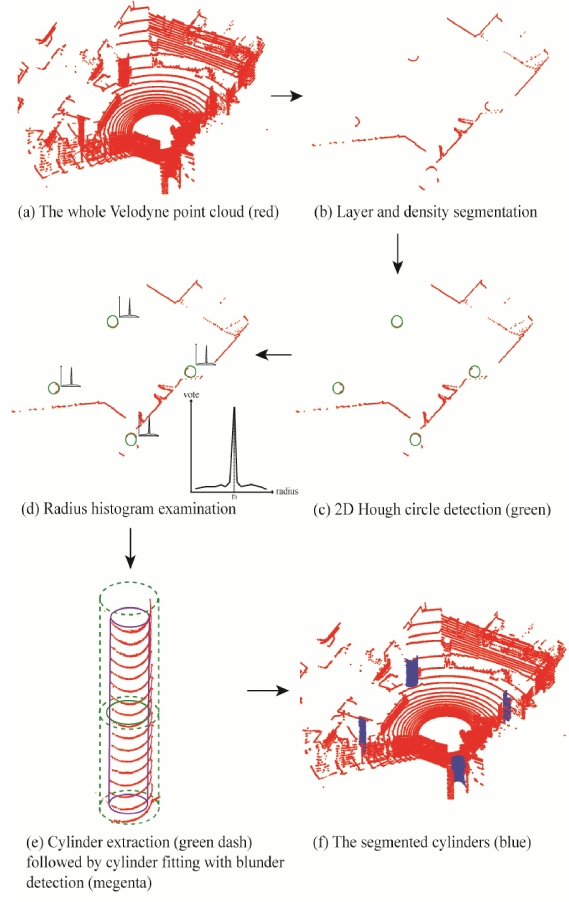
Figure 6. The proposed vertical cylinder segmentation process The cylindrical objects consist of multiple circular slices which can be detected using various methods. In our approach, the Generalized Hough Transform (GHT; Ballard, 1981) is used.